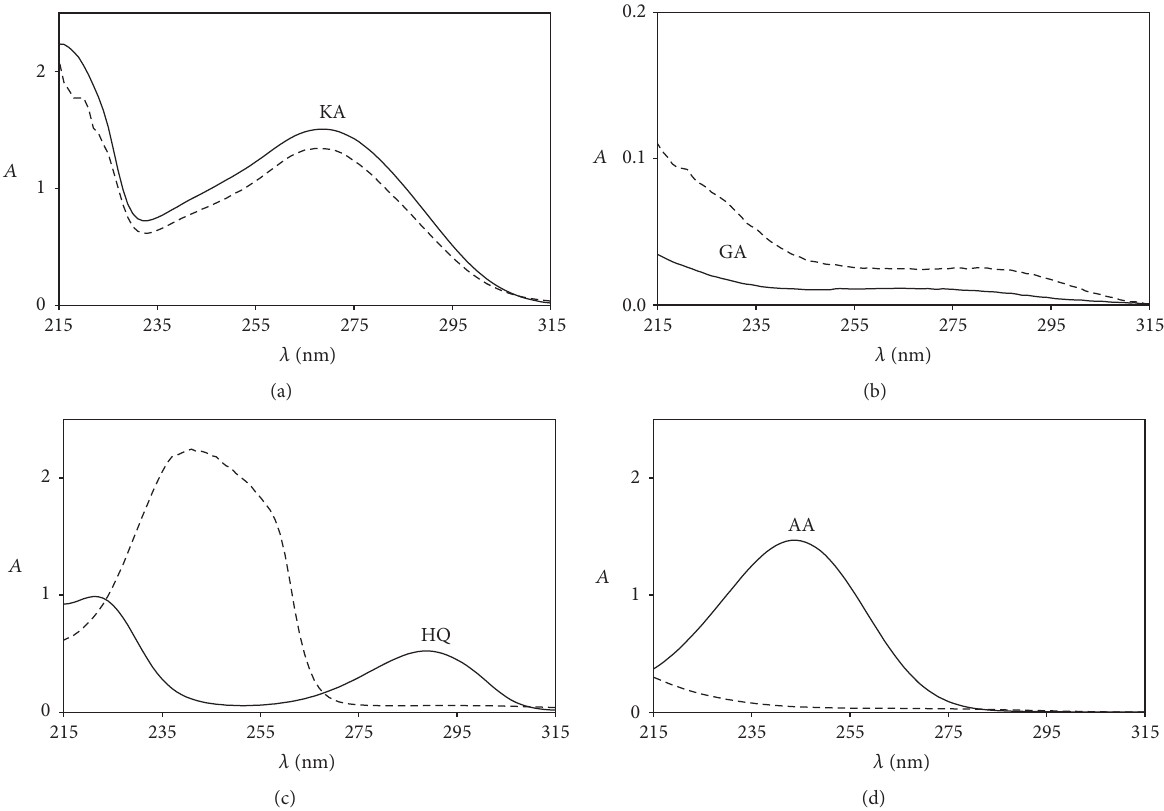
Figure 4: Overlaid spectra of the studied compounds in the absence (solid lines) and in the presence (dashed line) of K 2 Cr 2 O 7 in 1mol ⋅ L −1